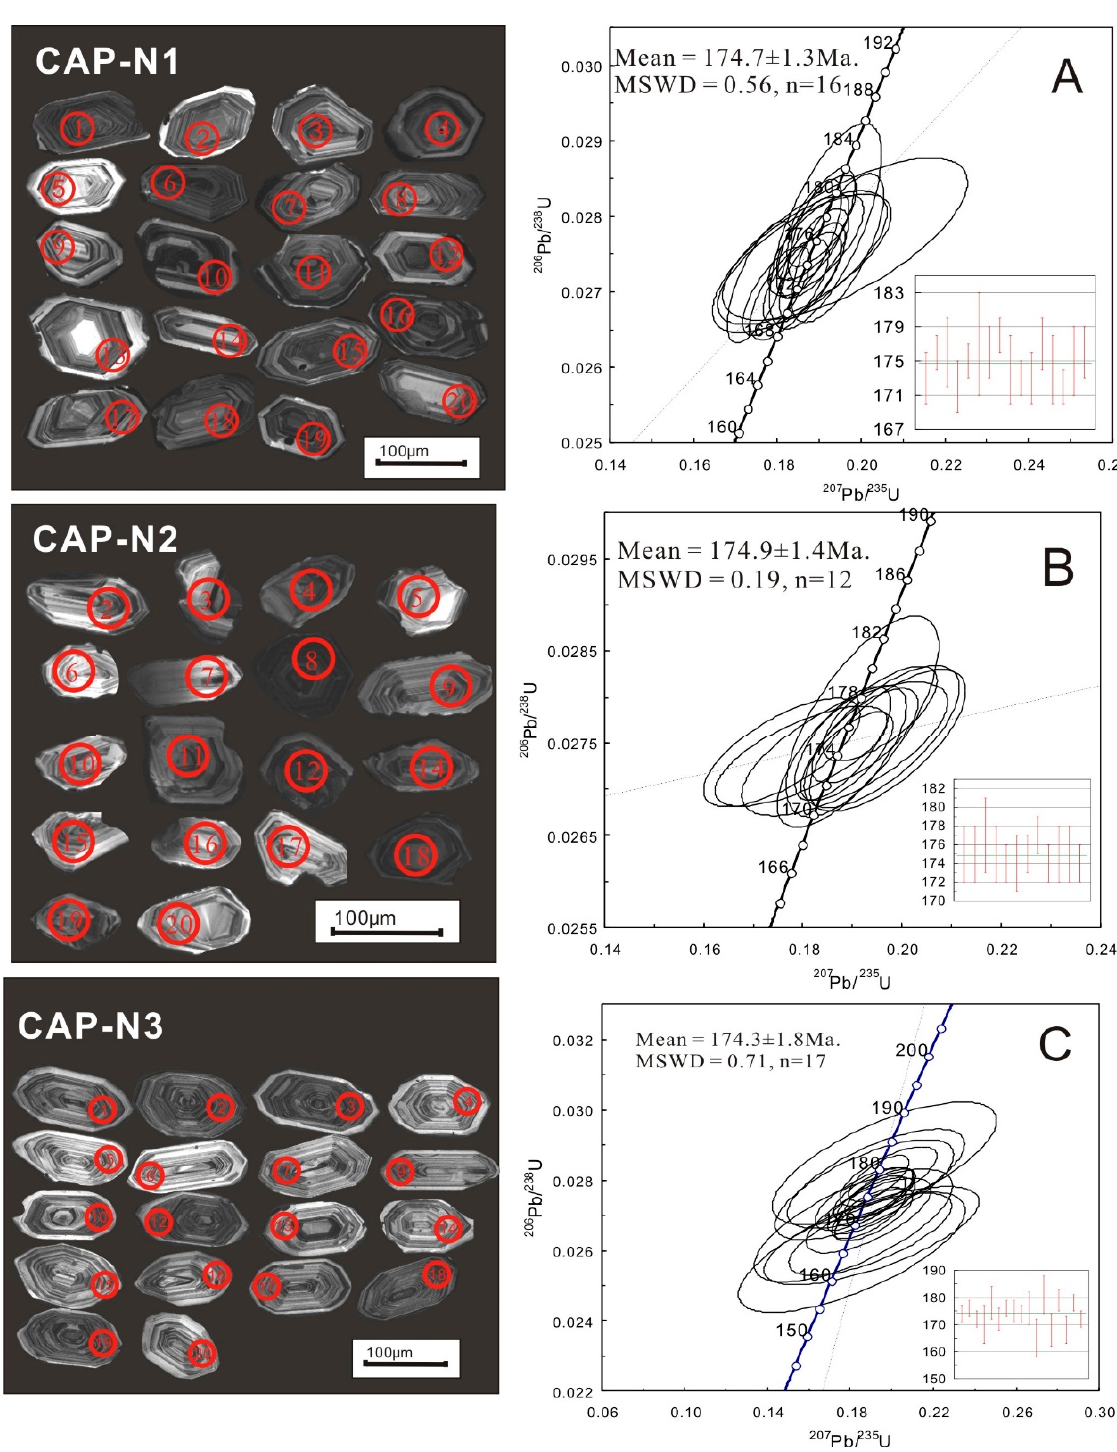
Figure 5. Cathodoluminescent images and LA-ICP-MS zircon U–Pb concordia diagrams for the monzogranite. ( A ) CAP-N1, ( B ) CAP-N2, ( C ) CAP-N3. Table 3. Results of LA-ICPMS U–Pb dating for the single-grain zircon from the monzogranite. Spot No.